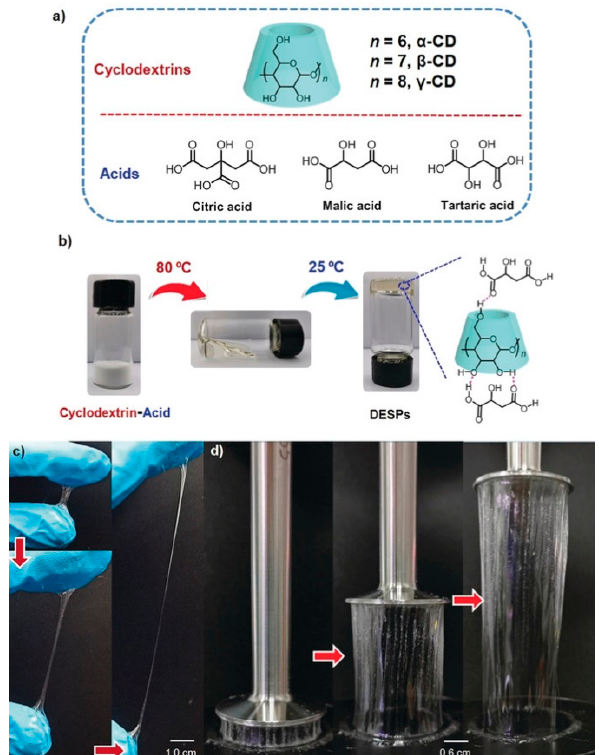
Figure 8. Images ( a ) and ( b ): supramolecular gels (“Deep eutectic supramolecular polymers”) based on the physical mixing of various cyclodextrins with natural acids. Images ( c ) and ( d ): drawn fibers and films from these gels cast from gloves and rheology plates. Reproduced with permission from [112], John Wiley and Sons.